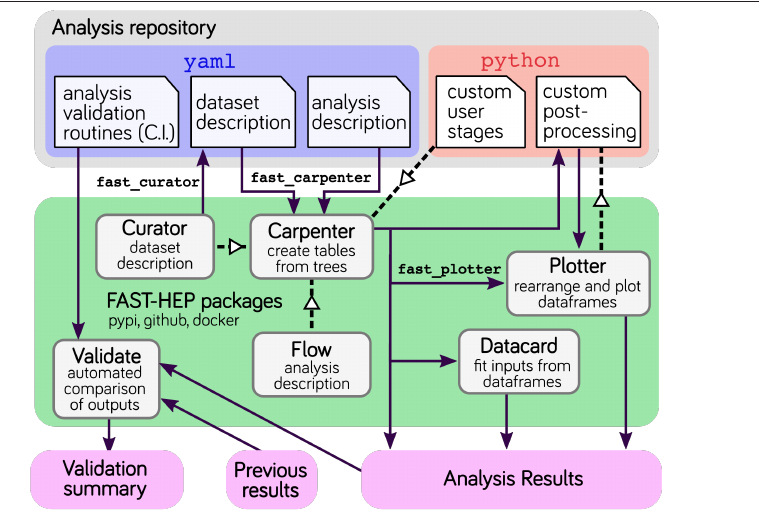
Figure 1: The interplay between FAST-HEP packages, a user’s repository, and the analysis results. A user’s repository contains mainly YAML files and some custom python code, which are used to control the FAST-HEP packages. Command-line programs are shown in typewriter fonts along